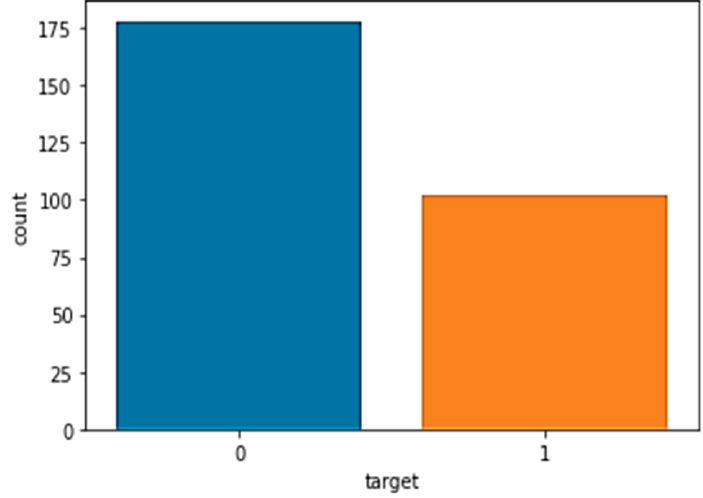
Figure 6. Histogram representing the targeted values.